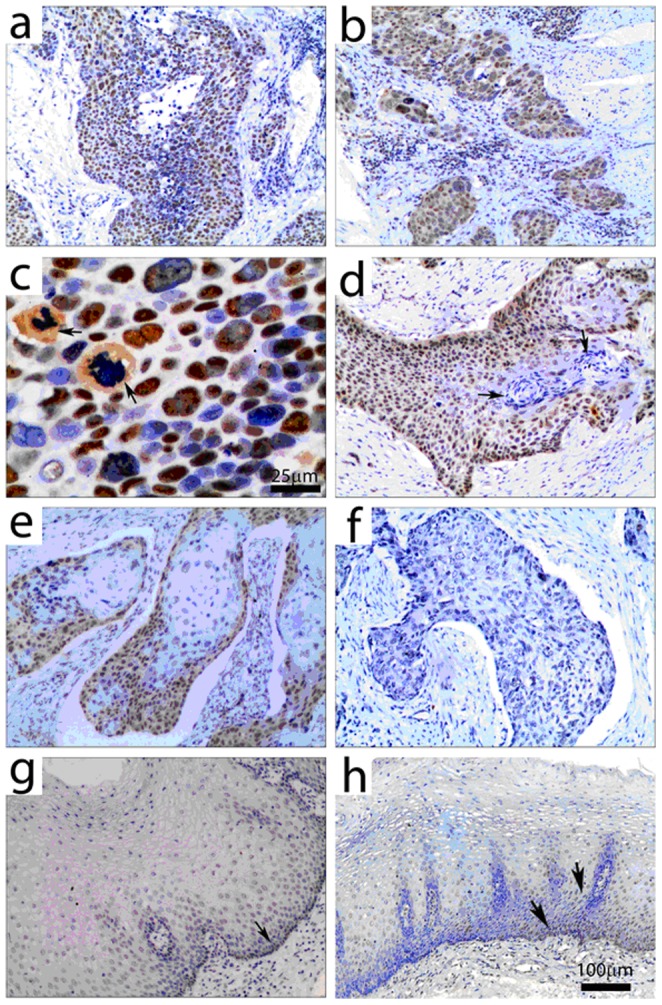
Immunohistochemical detection of WRAP53 protein expression in esophageal carcinoma and in adjacent non-neoplastic esophageal mucosa.(a) WRAP53 protein is visualized by yellow or brownish yellow staining in ESCC tissues. (b) Nuclear WRAP53 expression in ESCC tissues and weak or absent WRAP53 expression in the adjacent muscularis. (c) Strong expression of WRAP53 protein in poorly differentiated ESCC tissue. (d) and (e) Positive expression of WRAP53 in the well-differentiated ESCC tissue. (f) Negative WRAP53 expression in ESCC tissue. (g) and (h) Expression of WRAP53 is weak in adjacent non-neoplastic esophageal mucosa and is limited in basal and/or suprabasal layer cells. Scale bar  = 25 micron in c and 100 micron in all other figures.